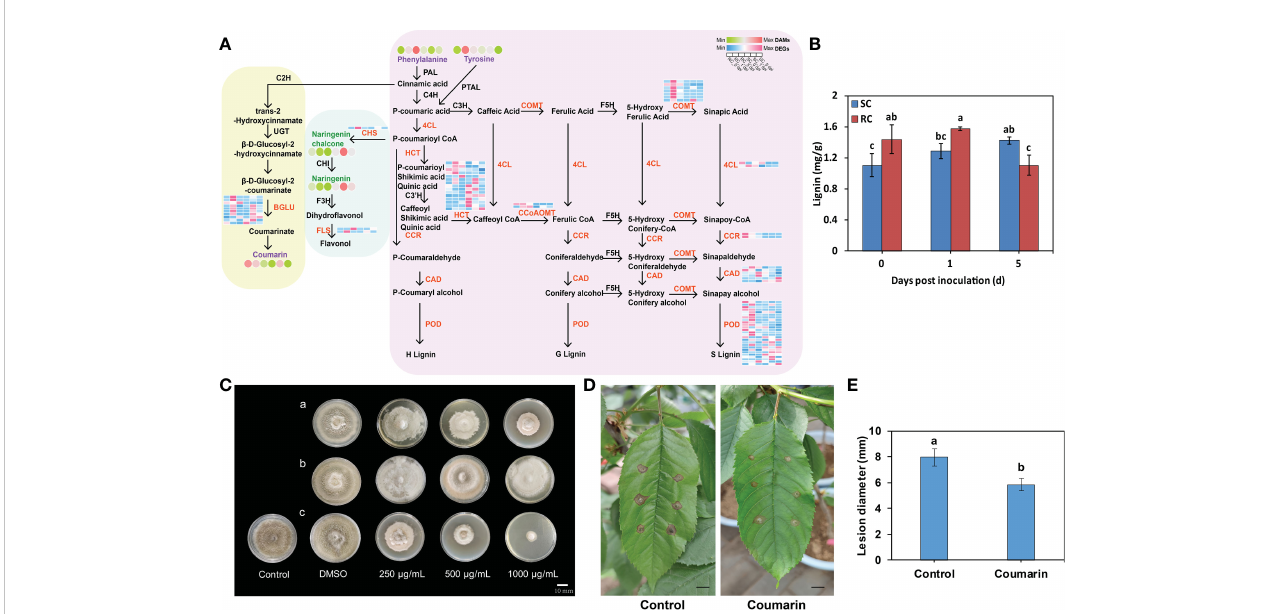
FIGURE 7 DEGs and DAMs involved in the phenylpropanoid pathway in the SC and RC inoculated with A alternata . (A) Schematic representation of the core pathway of phenylpropanoid biosynthesis; the circle heat map and the square heat map represent the expression of DAMs and DEGs, respectively, in the SC and RC at the three stages of testing. (B) The lignin content of the SC and RC at 0, 1, and 5 dpi. Error bars represent standard deviation (n = 3). Different letters above the bars indicate signi fi cant differences at the 0.05 level according to Duncan ’ s multiple range test. (C) Effect of the metabolites on A. alternata growth. Tyrosine (a) and coumarin (c) inhibit the growth of A. alternata , while phenylalanine (b) does not. DMSO (dimethyl sulfoxide) was used as the solvent control. Scale bar = 10 mm. (D) Effect of coumarin on growth of A. alternata in RC leaves. Scale bar = 10 mm. (E) Effect of coumarin on lesion diameter of RC leaves. Error bars represent standard deviation (n = 3). Different letters above the bars indicate signi fi cant differences at the 0.05 level according to Duncan ’ s multiple range